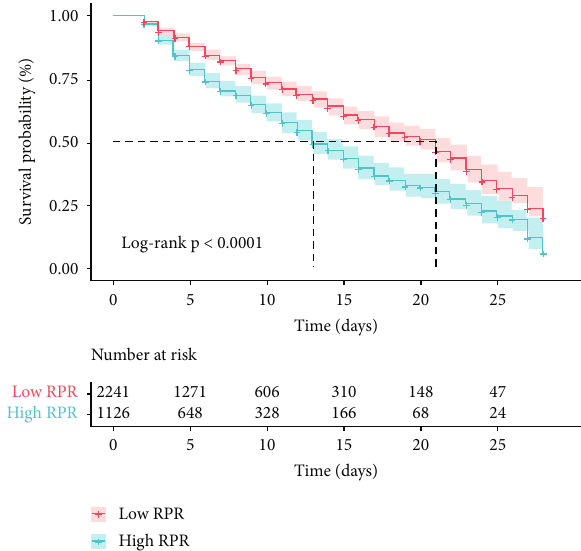
Figure 3: Kaplan-Meier analysis of 28-d mortality by the RPR levels in patients with sepsis. The 28-d mortality rate in the high RPR group was signi fi cantly higher than that in the low RPR group (log-rank test, P < 0 : 001 ). RPR: red cell distribution width to platelet ratio.